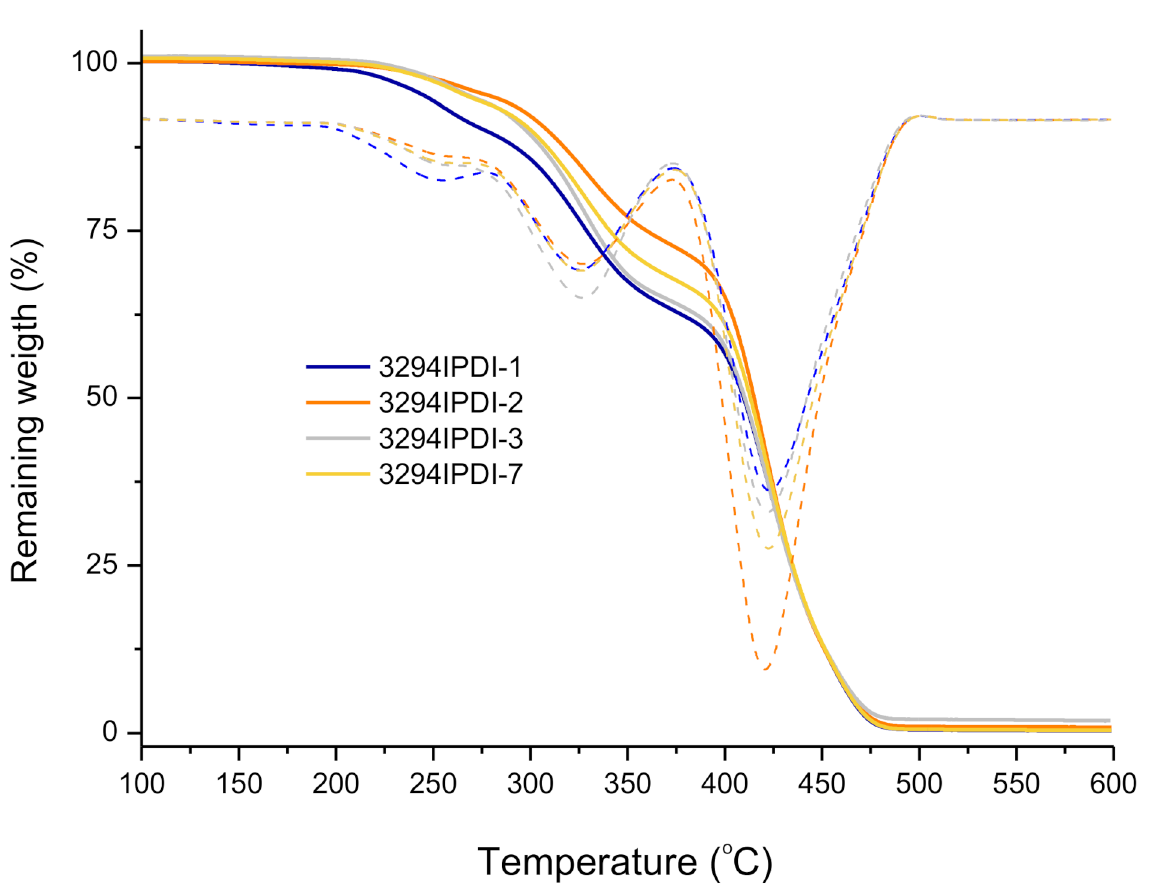
Figure 9. TGA thermograms of synthesized WPUD films. Mass losses (thick lines) and derivative curves (dashed